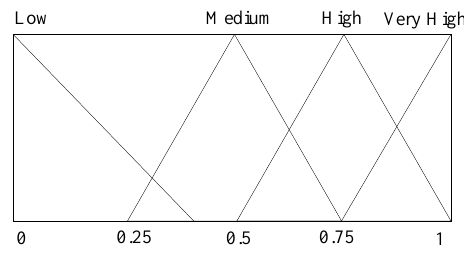
Figure 7. The membership of resource utilization.